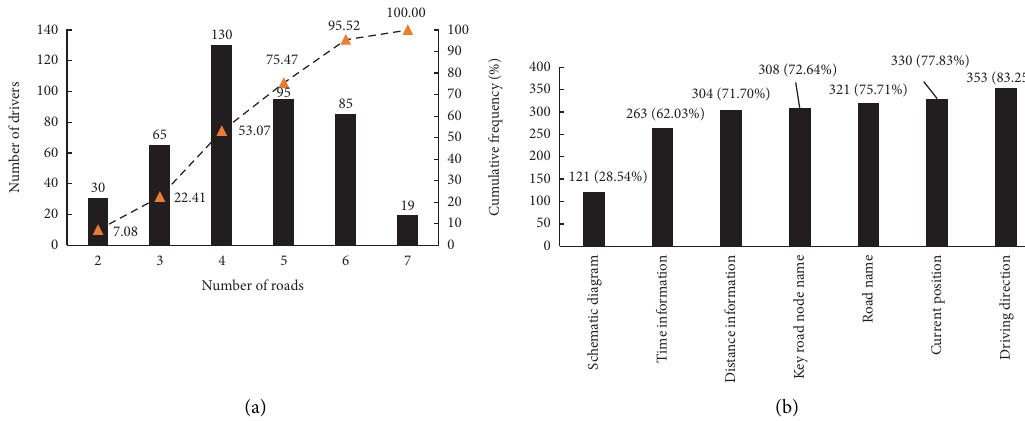
Figure 4: Statistical results of the subjective questionnaire survey. (a) Maximum number of roads accepted by drivers and (b) preference for elements showing on VMS.